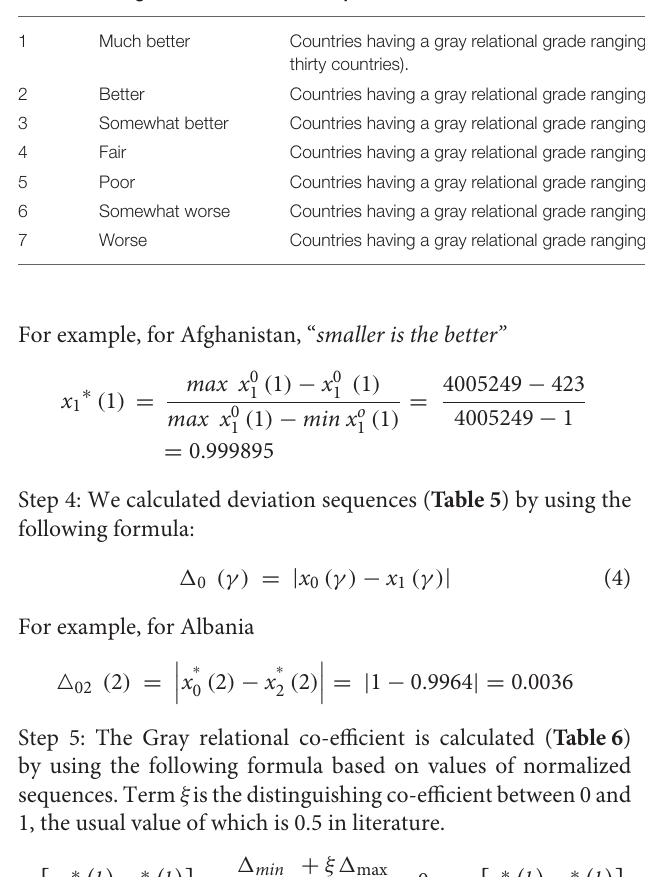
TABLE 8 | Scheme of grouping the countries under different ensigns on the basis of gray relational grades of health systems.